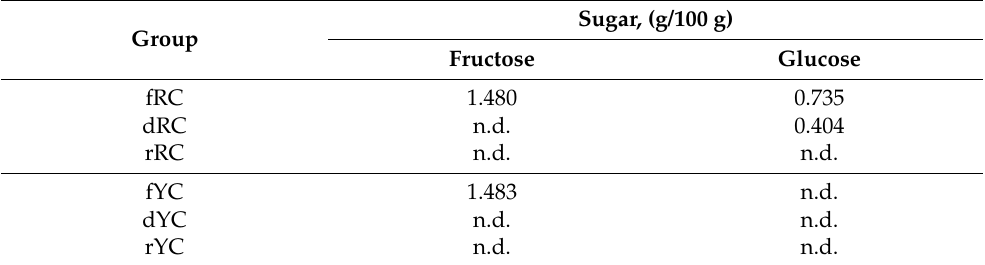
Table 5. Variation of soluble sugar pattern in differently treated polymorphic cacao beans *. Sugar, (g/100 g) Group Fructose Glucose fRC 1.480 0.735 dRC n.d. 0.404 rRC n.d. n.d. fYC 1.483 n.d. dYC n.d. n.d. rYC n.d.